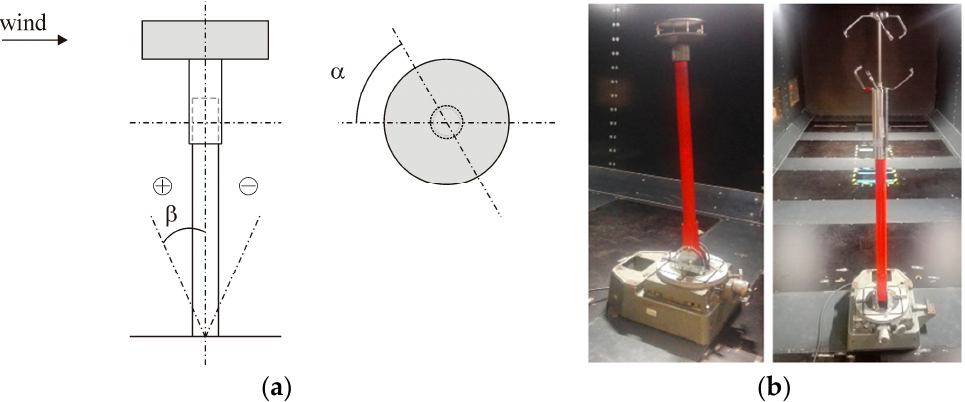
wind Figure 6. Anemometer settings: ( a ) scheme with definition of α and β ; ( b ) 2D and 3D devices in the wind tunnel.